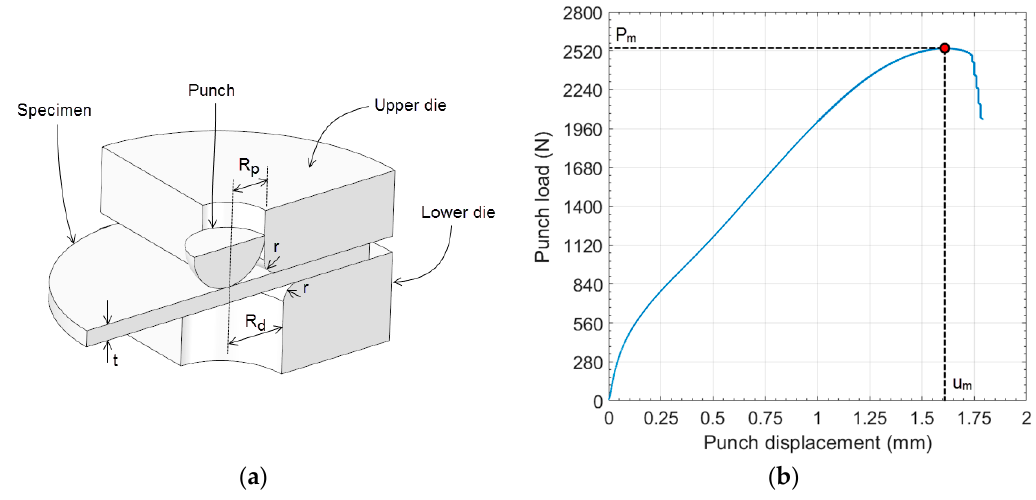
Figure 1. Small Punch Test (SPT) setup ( a ) and experimental load–displacement curve ( b ).